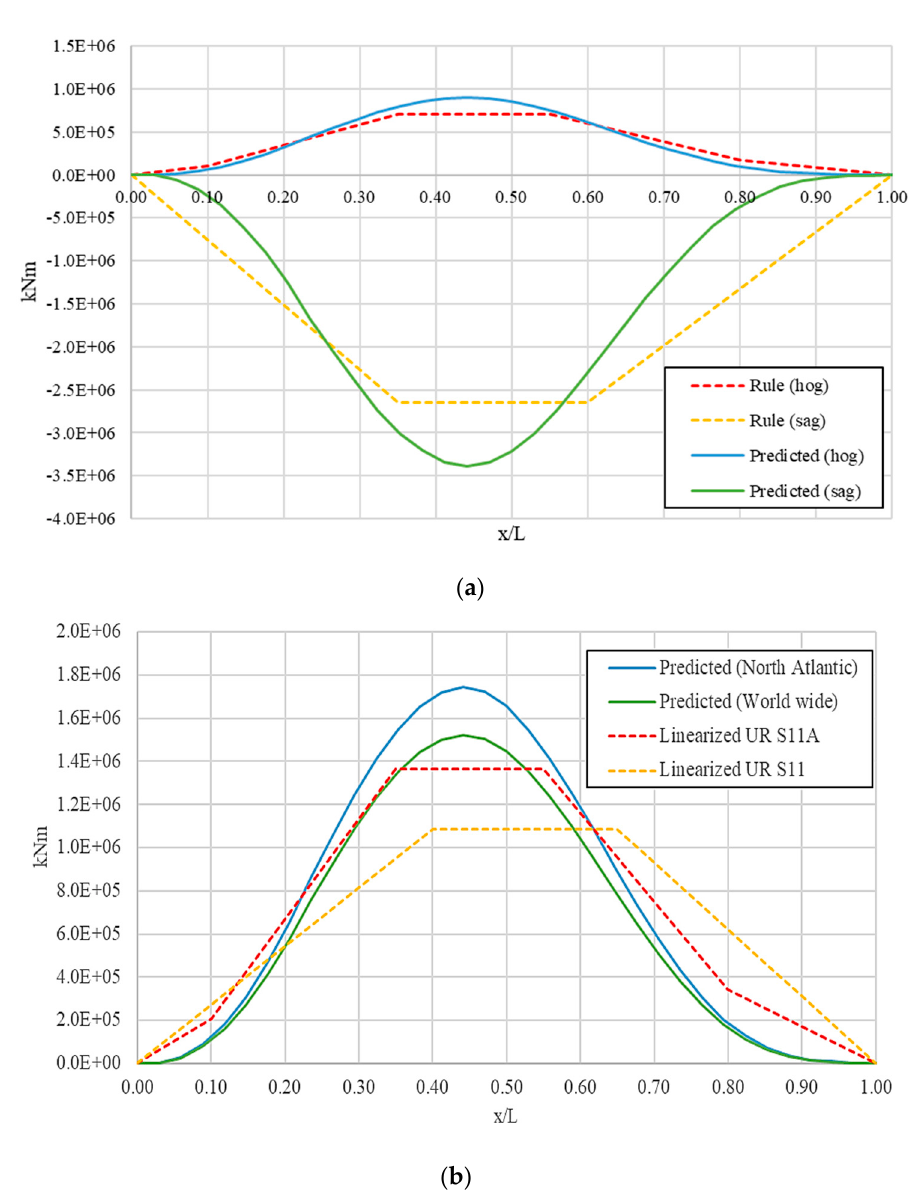
Figure 14. Long term load comparisons of ( a ) nonlinear VBM corrected predictions and IACS UR S11A requirement and ( b ) linear VBM predictions against linearized IACS UR S11 and S11A -requirements (10 − 8 probability level, 25 years return period).